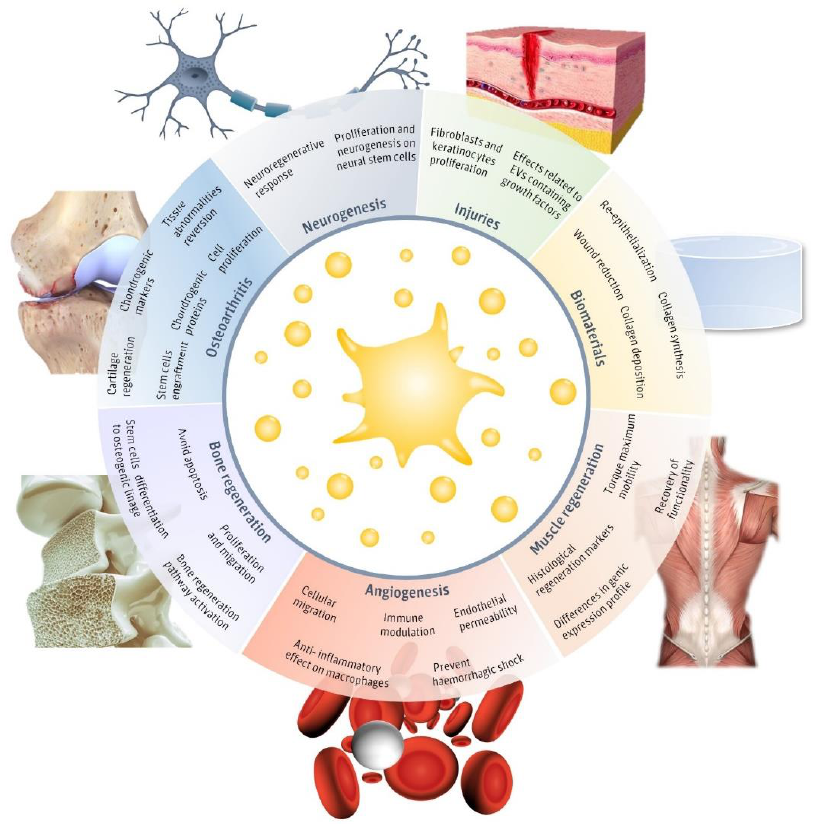
Figure 1. Regenerative applications of platelet-derived extracellular vesicles (pEVs). Main regenerative effects reported for pEVs in regenerative fields, including injuries [30 – 36], biomaterials [30,31], neurogenesis [37,38], muscle regeneration [39], angiogenesis [37,38,40 – 42], bone regeneration [25,26,43 – 45] and osteoarthritis [46 – 49] and the major reported thera- peutical effects. This figure was created using Freepik images. was created using Freepik